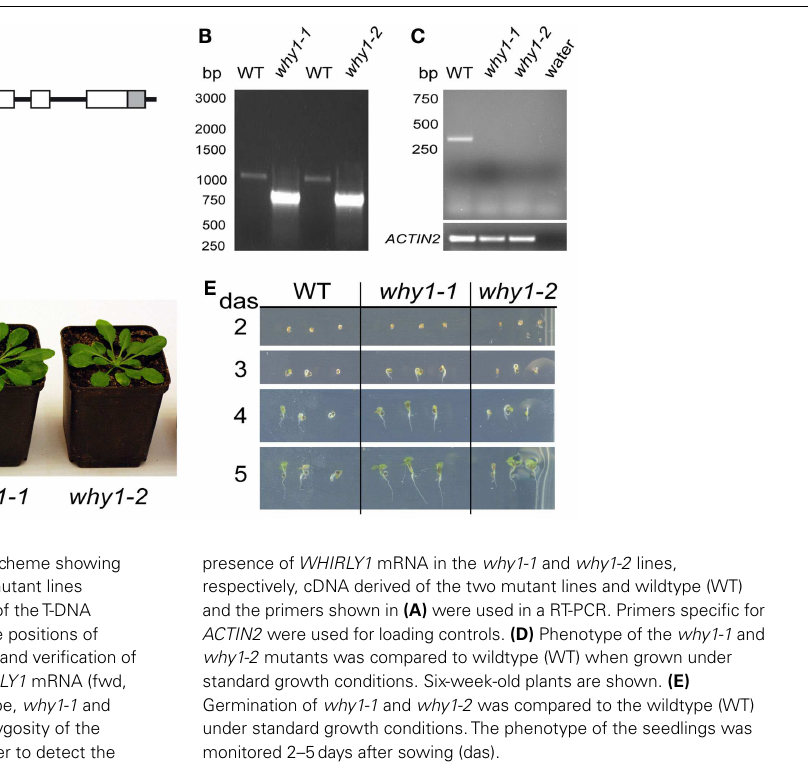
FIGURE 1 | Characterization of why1 mutants. (A) Scheme showing the positions ofT-DNA insertions in two independent mutant lines ( why1-1 and why1-2 ) for the WHIRLY1 gene.The sites of theT-DNA insertions are indicated by arrowheads. Additionally, the positions of primers used for homozygous screening (LP, LBa1, RP) and verification of the presence of the initial start codon ATG in the WHIRLY1 mRNA (fwd, rvs) are shown. (B) Genomic DNA derived from wildtype, why1-1 and why1-2 lines, respectively, was used to test for homozygosity of the mutants by use of the primers shown in (A) . (C) In order to detect the